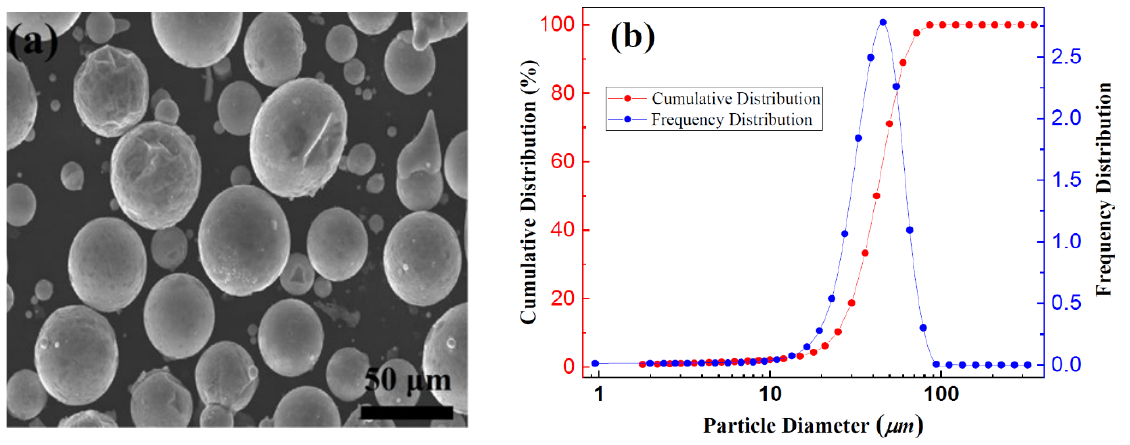
Figure 1. Mg-based alloy powders: ( a ) SEM image of the powders. ( b ) Size distribution of the powders.